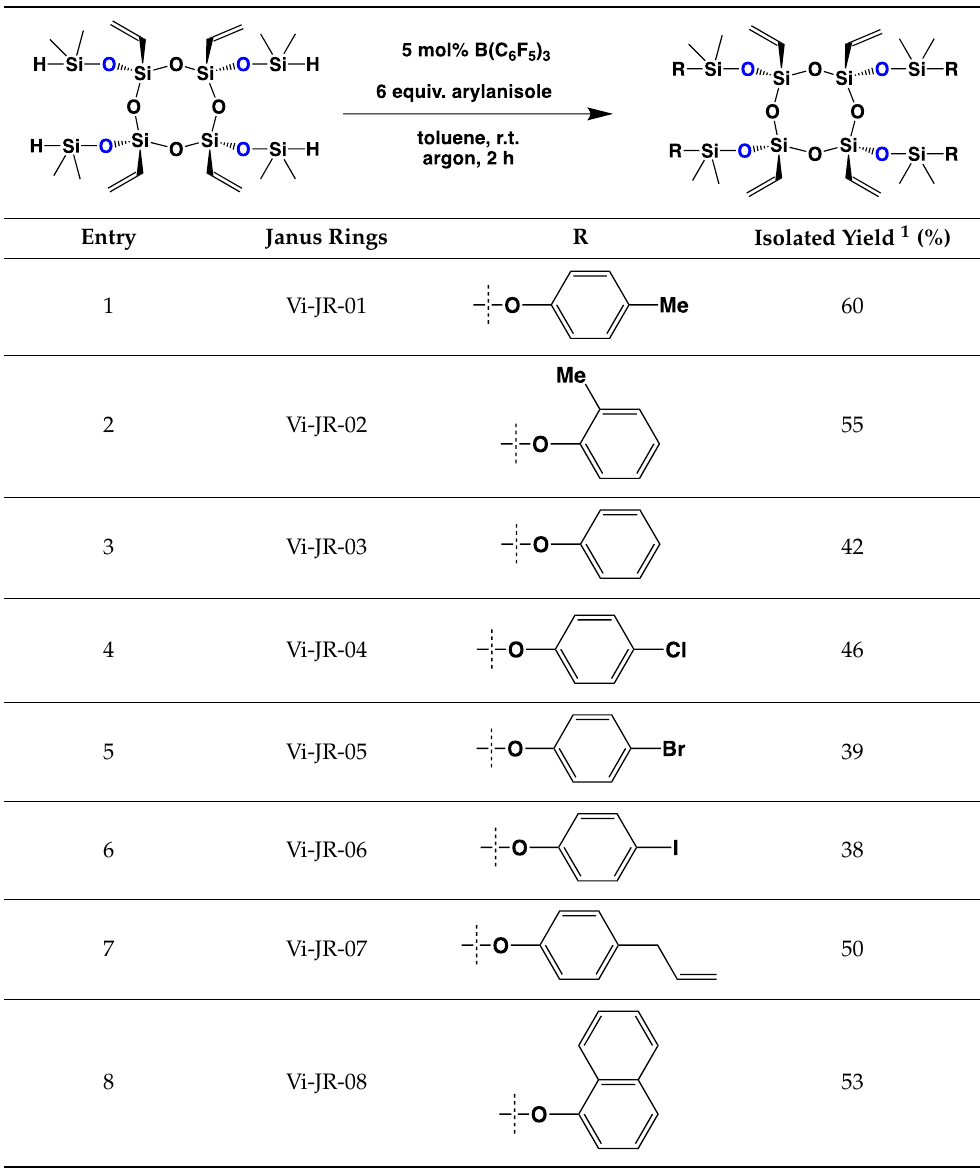
Table 1. The synthesis of Janus rings [ViSi(OSiMe 2 OR)O] 4 Vi-JR-01 to Vi-JR-08 by Piers–Rubinsztajn reaction from the Janus precursor [ViSi(OSiMe 2 H)O] 4 with an excess amount of aryl anisole.